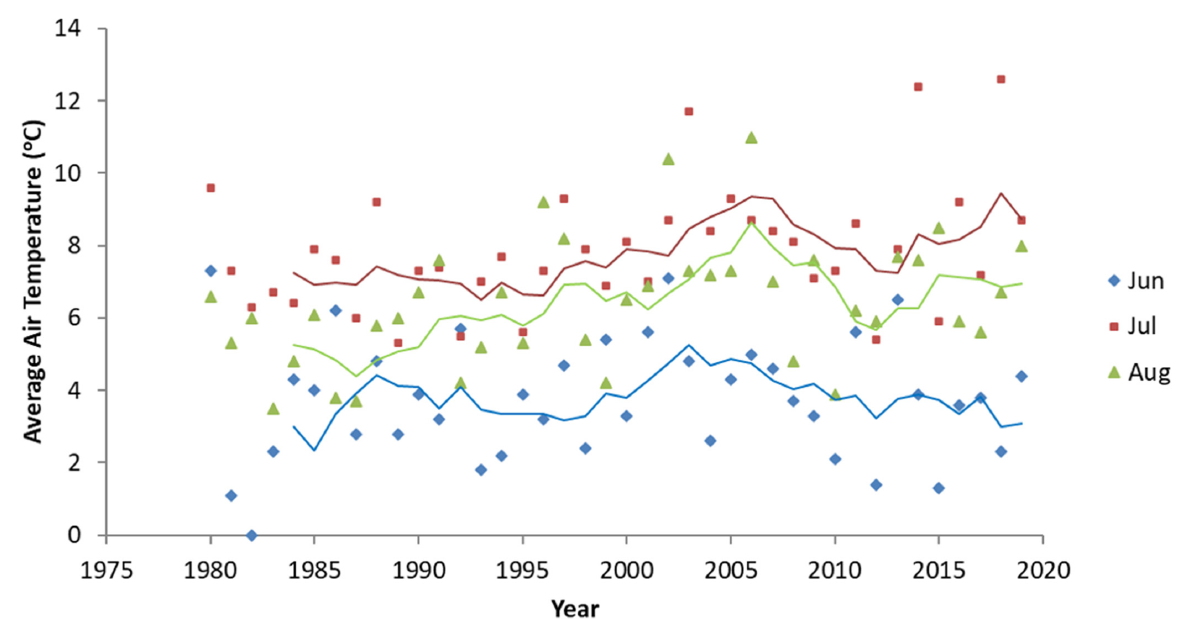
Figure 1. Monthly average air temperatures ( ◦ C) measured at 2 m above ground at Tarfala Research Station (67.9 ◦ N, 1143 m a.s.l.) for 1980 to 2019 with 5 year running means for June (blue), July (red), and August (green) (from SMHI and Bolin Centre). Data from 1980 to 1987 are from chart recorder-based automated data collection and from an automated weather station after 1987 (Bolin and SMHI).